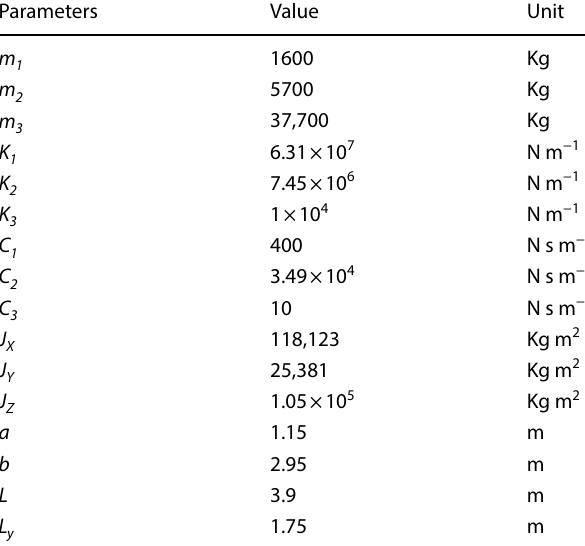
Table 1 Initial parameters for simulation [17, 18] Parameters